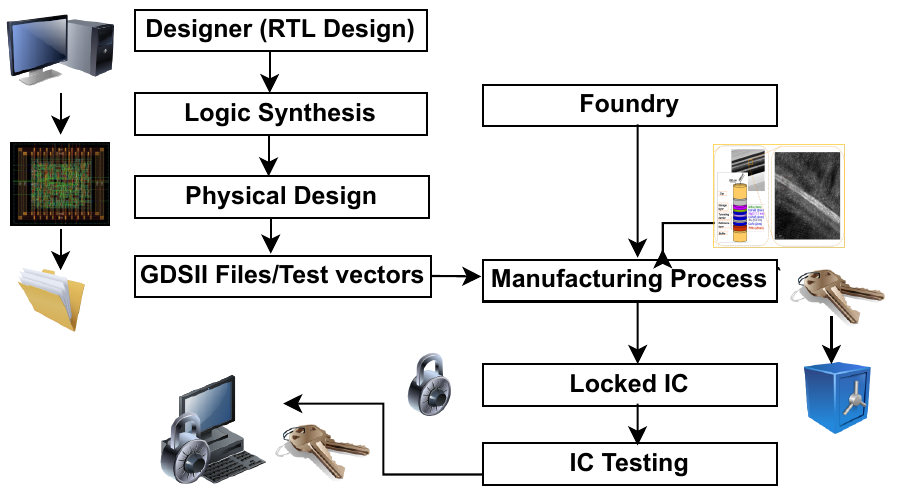
Figure 1. Overall IC design flow and logic locking with